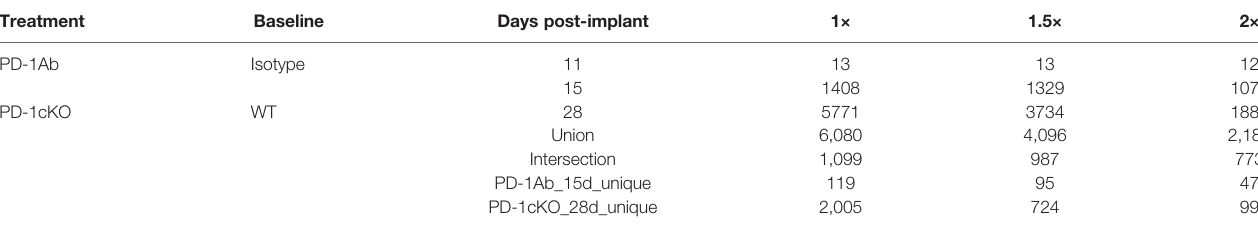
TABLE 1 | RNAseq analysis of tumor